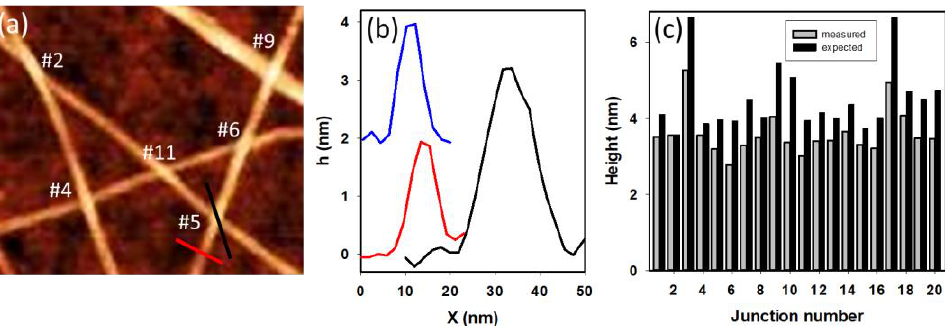
Figure 5. ( a ) AFM image of PFDD/SWCNTs showing several nanotube crossings. ( b ) Height profiles across the individual tubes (blue and red) and the crossing point (black) for junction #5. ( c ) Histogram showing comparison of measured junction heights and expected values based on the sum of the individual tube heights.